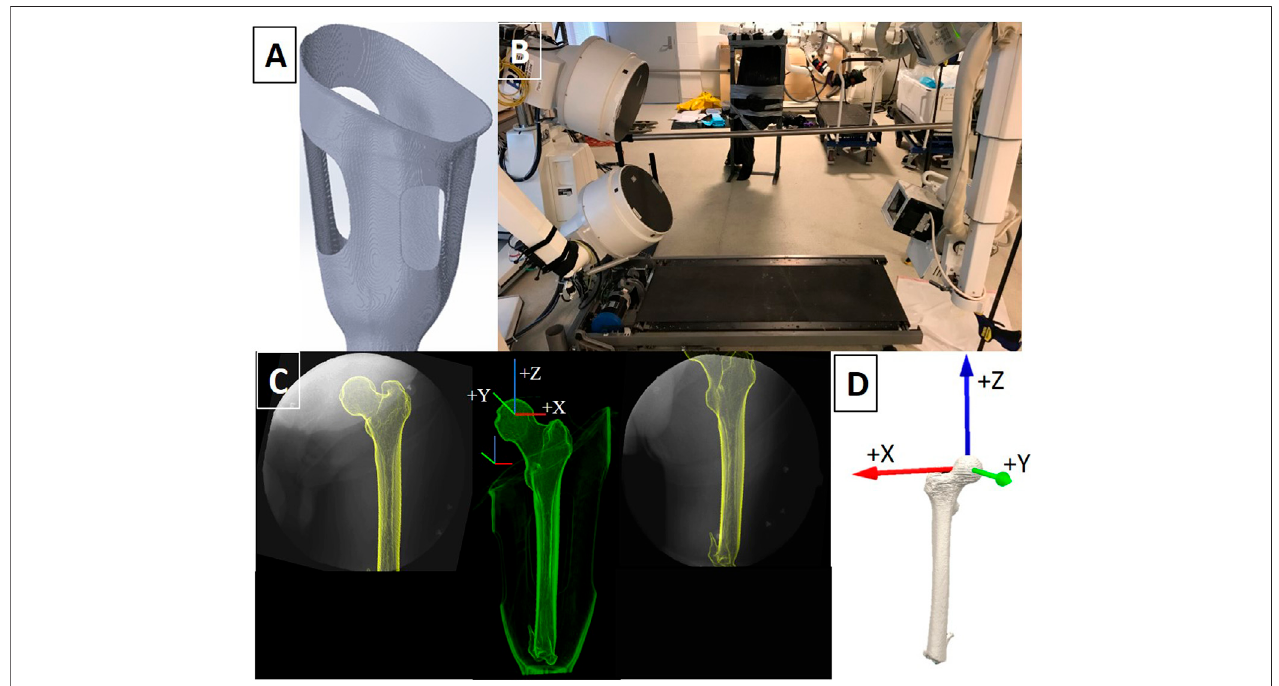
FIGURE 1 | (A) Example of a digitally rendered transfemoral CRS socket with longitudinal depressions (struts) and open windows to accommodate the displaced tissue. (B) The DSX system was set up to record dynamic x-ray sequences in a 60 ° anteroposterior orientation as participants walked on the treadmill. (C) X-ray fi eld of view images of the residual limb-socket complex from both x-ray views and the corresponding fusion of x-ray and CT imaging into a 3D entity. Femur and socket coordinate systems are displayed. (D) The anatomical coordinate system assigned to the residual femur was located at the center of the femoral head.